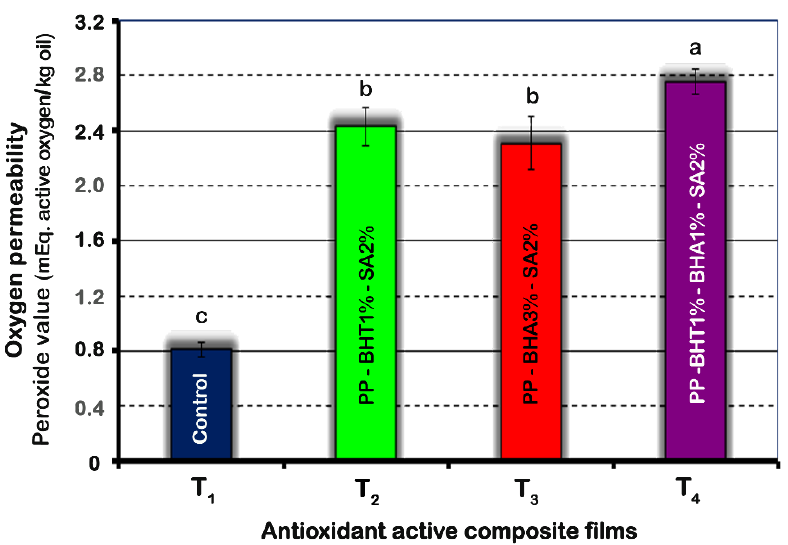
Figure 3. Effect of composition of polypropylene-based films on oxygen permeability of composite films. Means ( n = 3) with different letters are significantly different ( p < 0.05). Error bars corresponding to standard deviations.